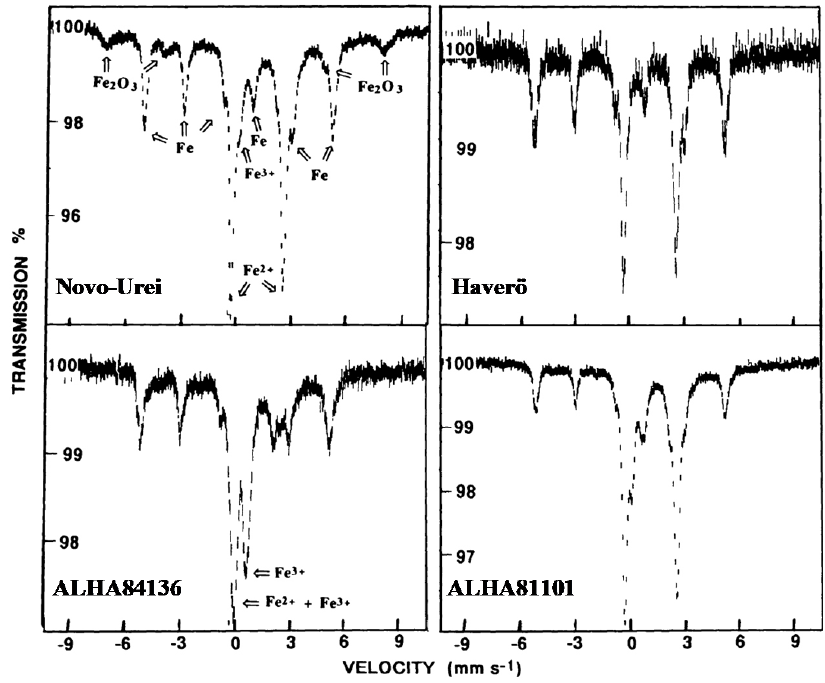
Figure 1. Room temperature Mössbauer spectra of ureilites Novo Urei, Haverö, ALHA84136, and ALHA81101. Adapted from [6].